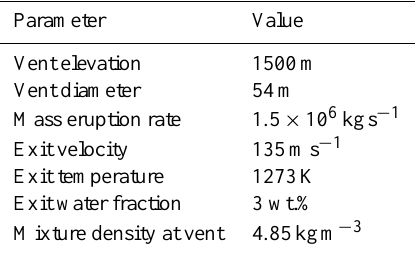
Table 2. Vent conditions for the weak volcanic plume